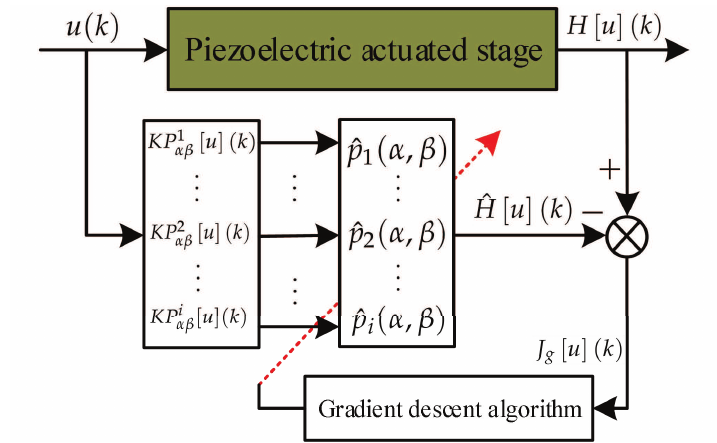
Figure 2. Identification structure diagram of the KP operators with the gradient descent